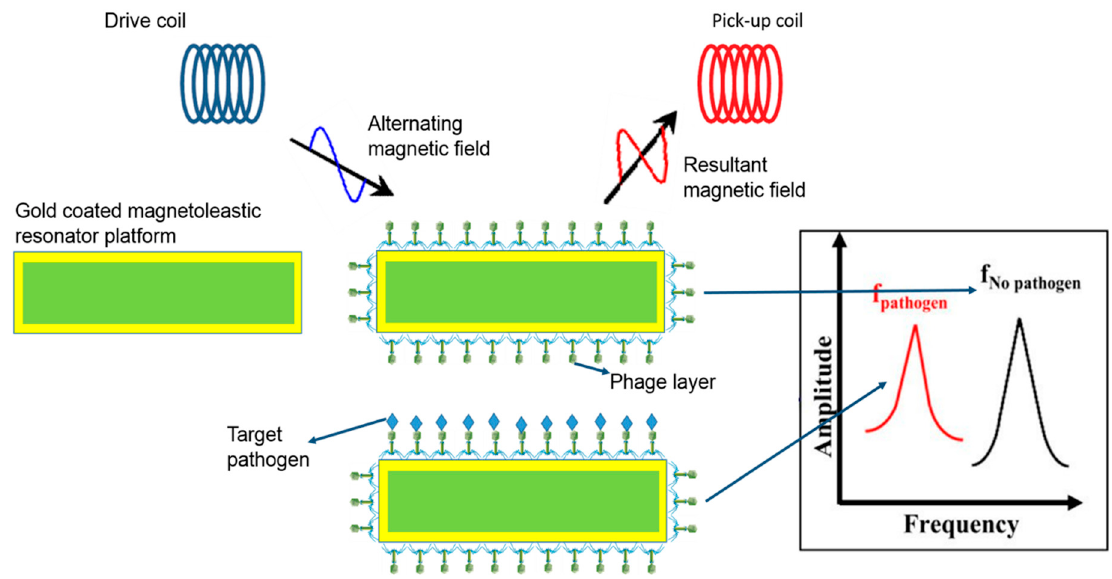
Figure 3. Schematic figure illustrating the working principle of ME biosensors.